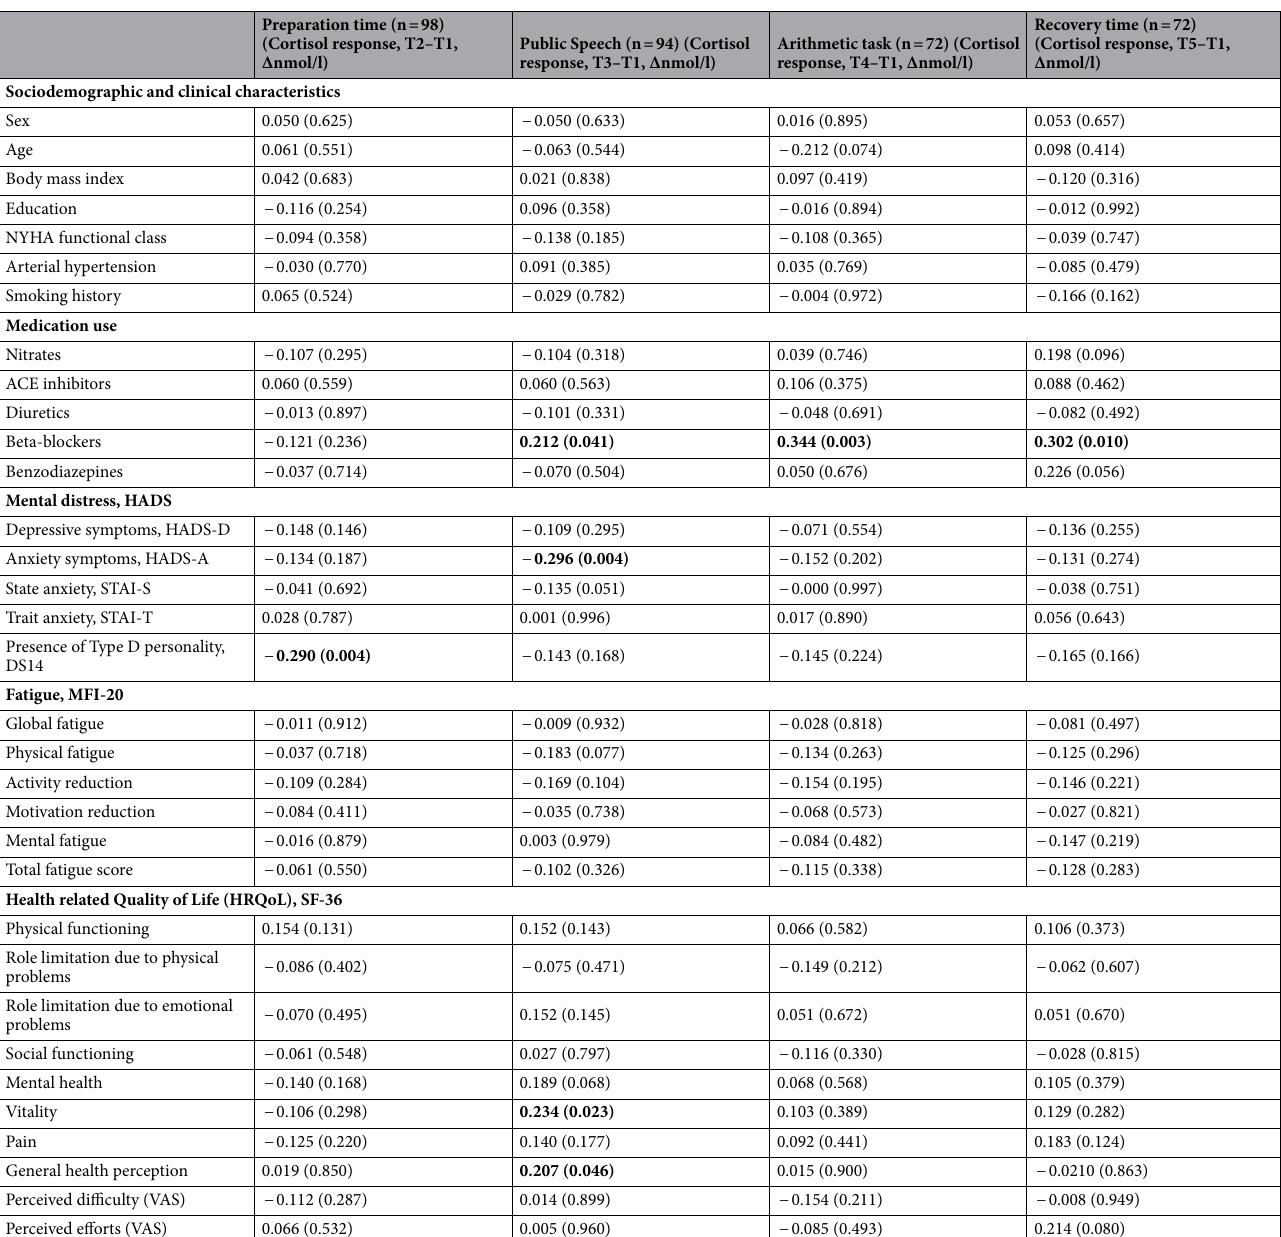
Table 2. The links between cortisol response to Trier Social Stress Test (TSST) in 6 phases and sociodemographic and clinical factors as well as mental distress, fatigue and health related quality of life (HRQoL) in study patients (n = 98). Univariate linear regression analyses, r’s (p). MFI-20 Multidimensional Fatigue Inventory 20-items, SF-36 36-Item Short Form Medical Outcome; Questionnaire, NYHA New York Heart Association, HADS-A Hospital Anxiety and Depression Scale, anxiety symptoms subscale, HADS-D Hospital Anxiety and Depression Scale, depressive symptoms subscale, DS14 Type D Scale-14, VAS Visual Analogue Scale, ACE Angiotensin-converting enzyme. Sex (male [1]; female [2]), education (high school [1]; college/university degree [2]), NYHA functional class (I-II class [1]; III class [2]), smoking (yes [0]; no [1]), medication use (yes [0]; no [1]), Type D personality (yes [0]; no [1]); Visual analog scale range 0–5. To evaluate cortisol response (delta scores), we subtracted the averaged values of the cortisol measures (nmol/l) during Baseline rest from the averaged values during other TSST phases. *Significant correlations (p value < .05) in